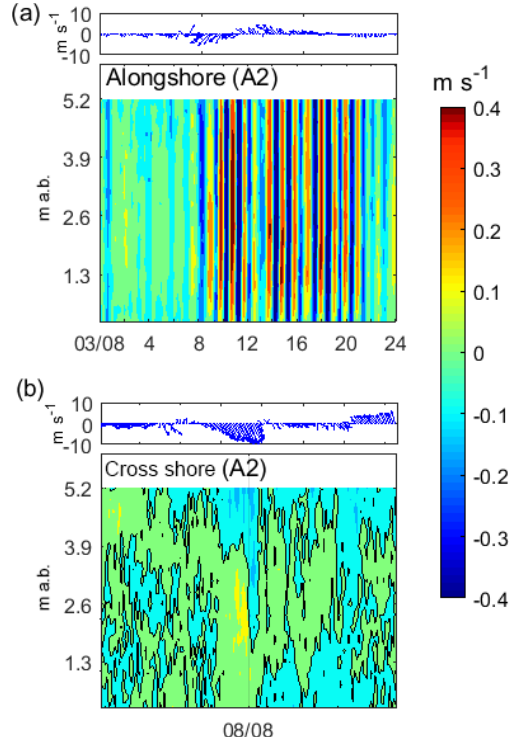
Figure 3. Each panel shows (at the top) the wind speed measured at M-Sc in ms − 1 . At the bottom the vertical profiles show the speed measured at A2 (in ms − 1 ; mab stands for metres above the bottom). Black lines show the zero speed isolines. Different events are shown in each panel: (a) for the along-shore direction on 3 August 2013, and (b) for the cross-shore direction on 8 August 2013.